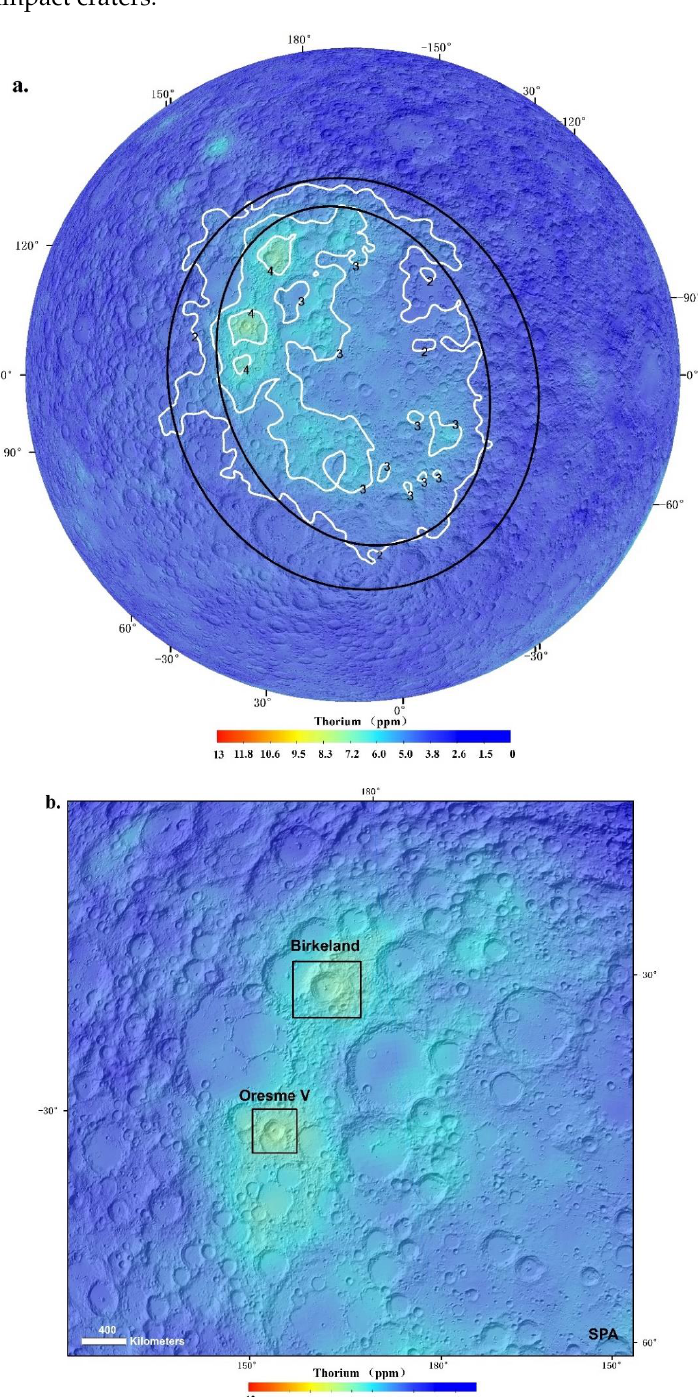
Figure 3. Thorium abundance from LP gamma-ray spectrometer (Reprinted/adapted with permis- sion from Ref. [11]. 1998, Lawrence, D.J.) overlain on LOLA hillshade map. ( a ) The white outline represents the Th contour (the black numbers is the Th value with ppm as units) within SPA and corre- sponds to the 2 ppm Th value contour. Black ovals represent two SPA basin rings (Reprinted/adapted with permission from Ref. [18]. 2009, Garrick-Bethel and Zuber) ( b ) Enlarged map of NW SPA interior showing the craters Birkeland and Oresme V, which show relatively higher Th values (>4 ppm Th) in their